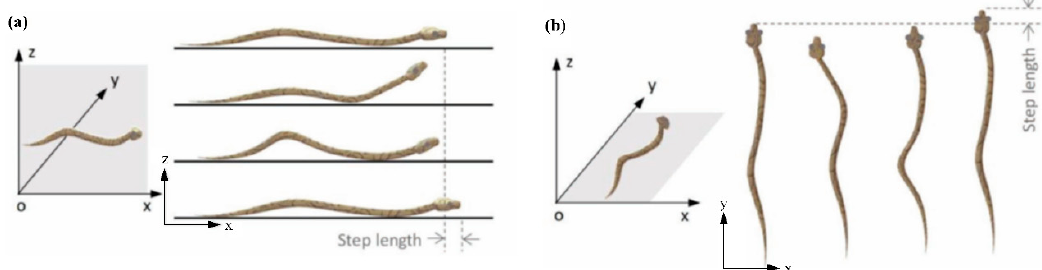
Figure 1. Mechanisms of a snake’s locomotion. ( a ) Snake’s concertina locomotion and ( b ) snake’s serpentine locomotion [25] (with permission).